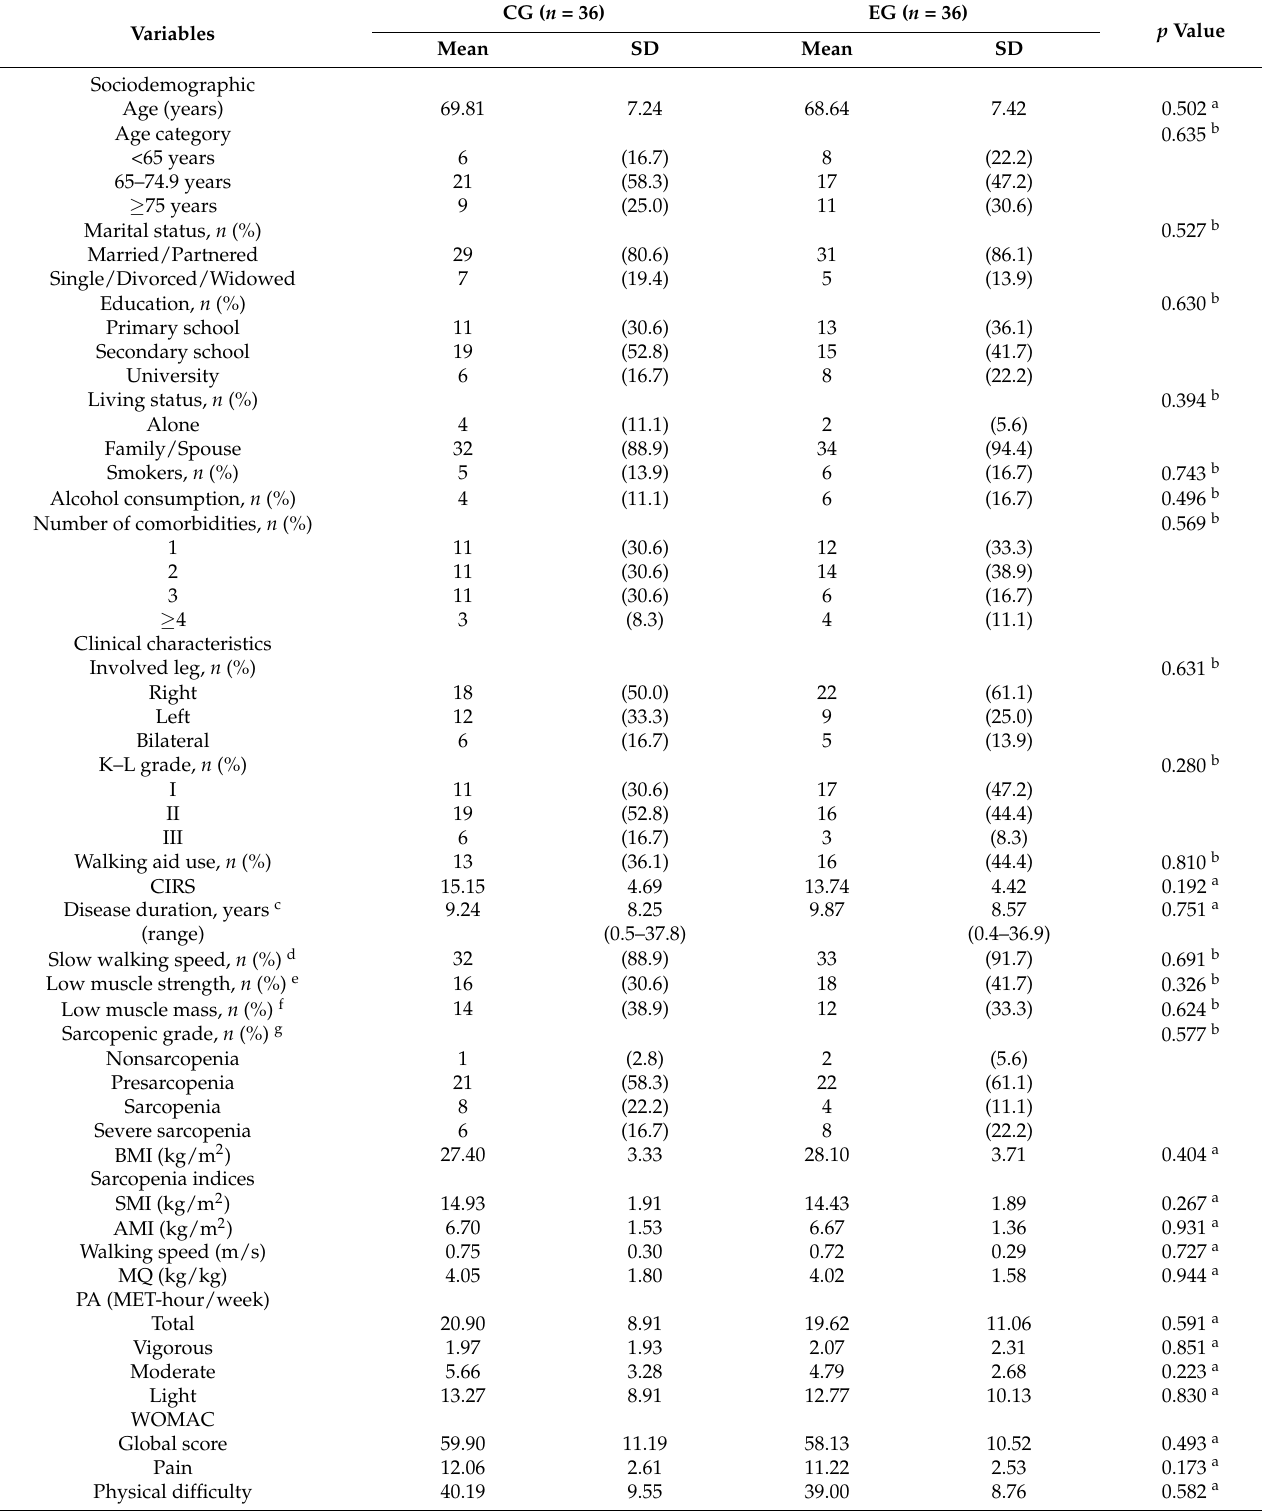
Table 1. Demographic characteristics of the